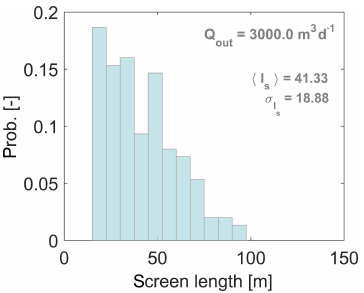
Figure A1. Probability histogram of the simulated screen lengths.